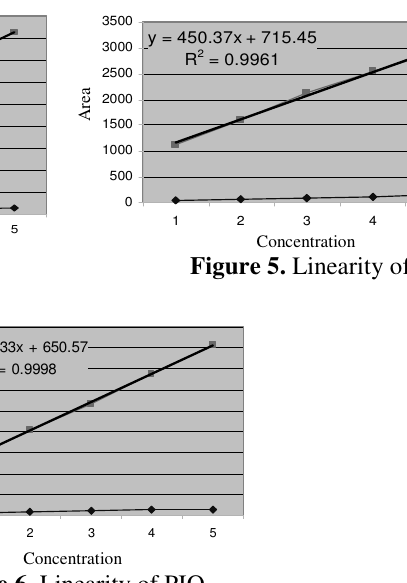
Figure 6. Linearity of PIO